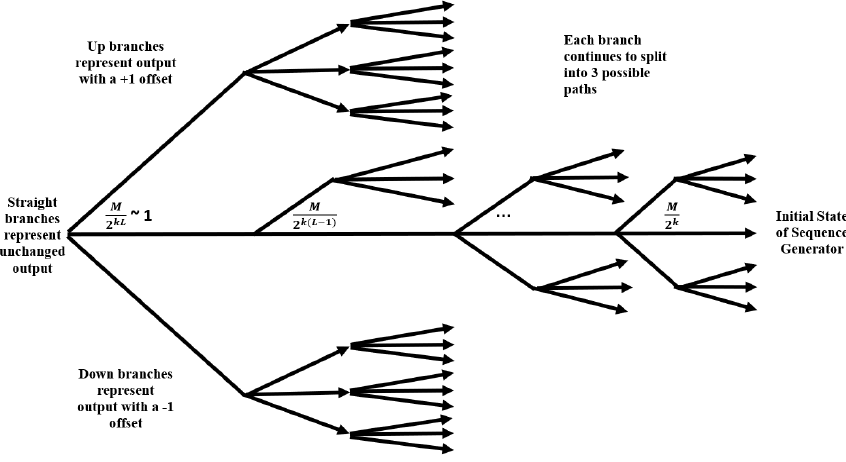
Figure 17. Multi − error